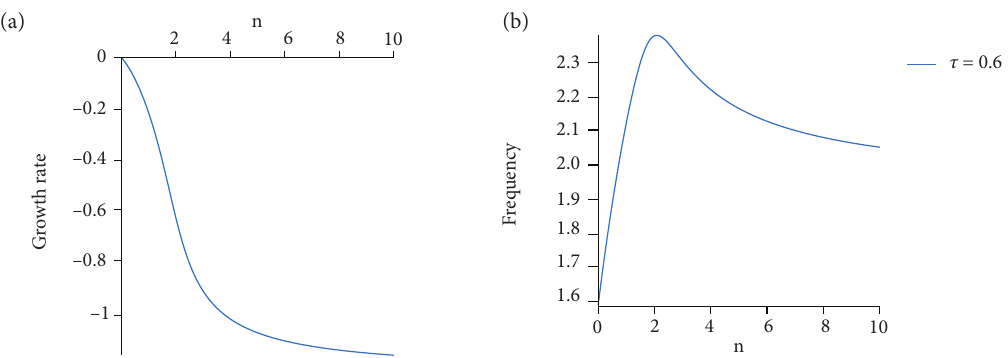
Figure 3. Nominal thermoacoustic characteristics for duct (1L mode) showing (a) growth rate and (b) frequency.